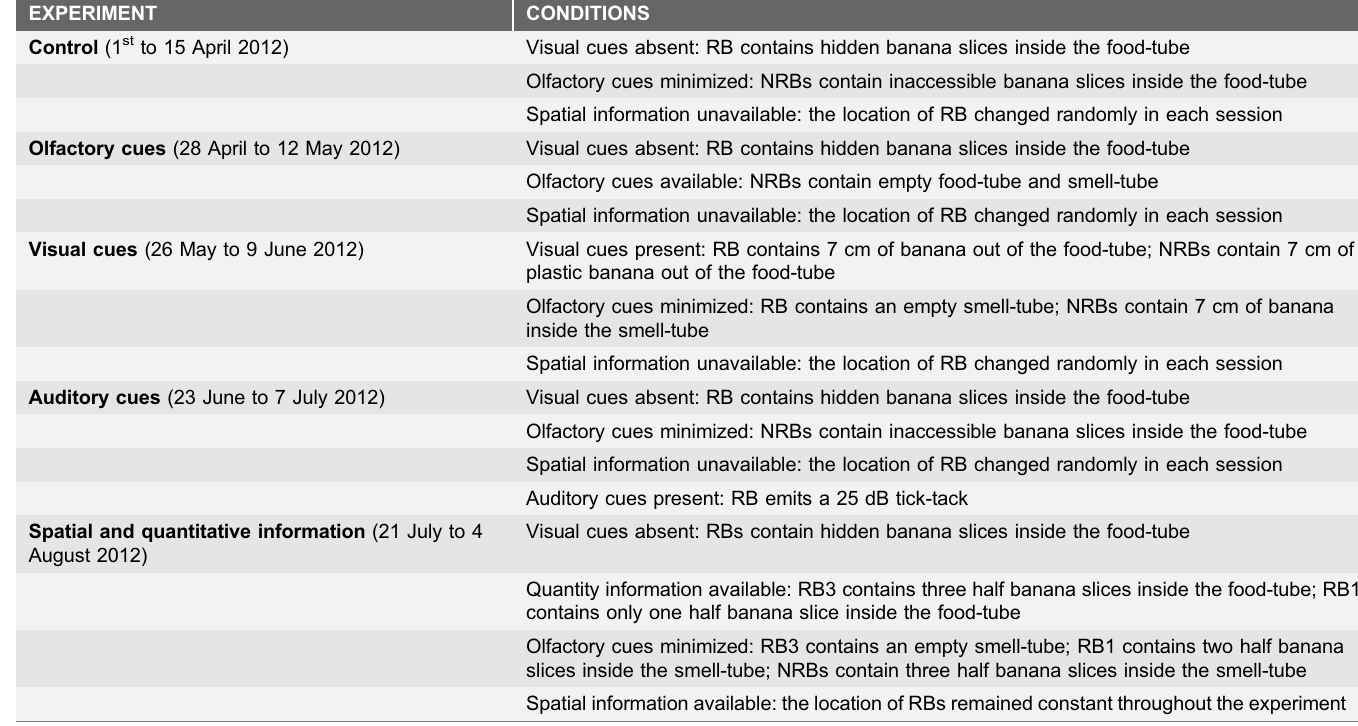
Table 1. Description of the experiments and time they were